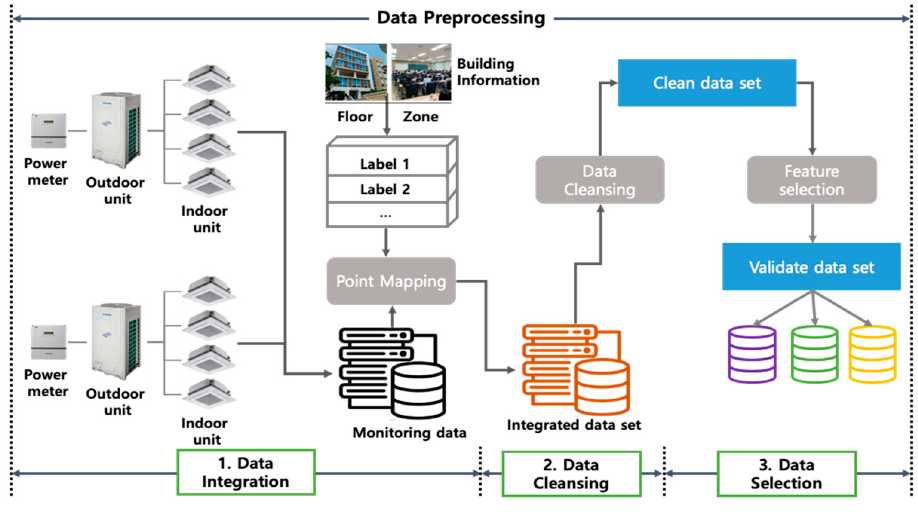
Figure 2. Data preprocessing. 157